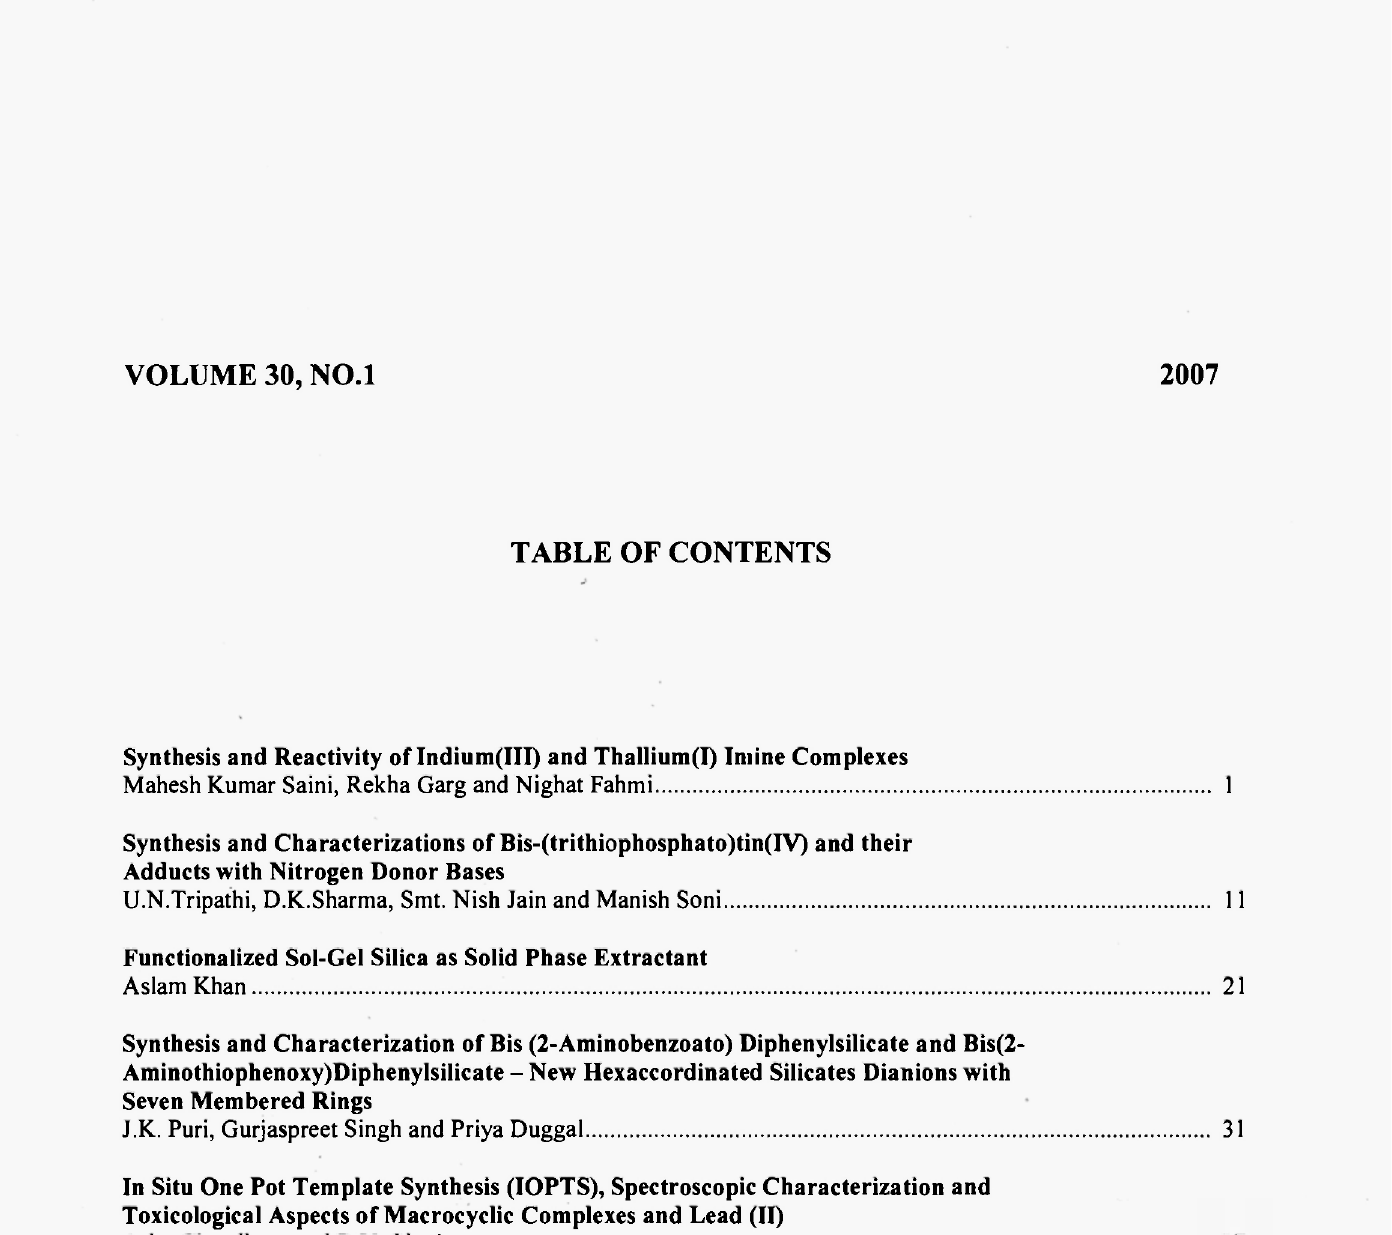
Functionalized Sol-Gel Silica as Solid Phase Extractant Aslam